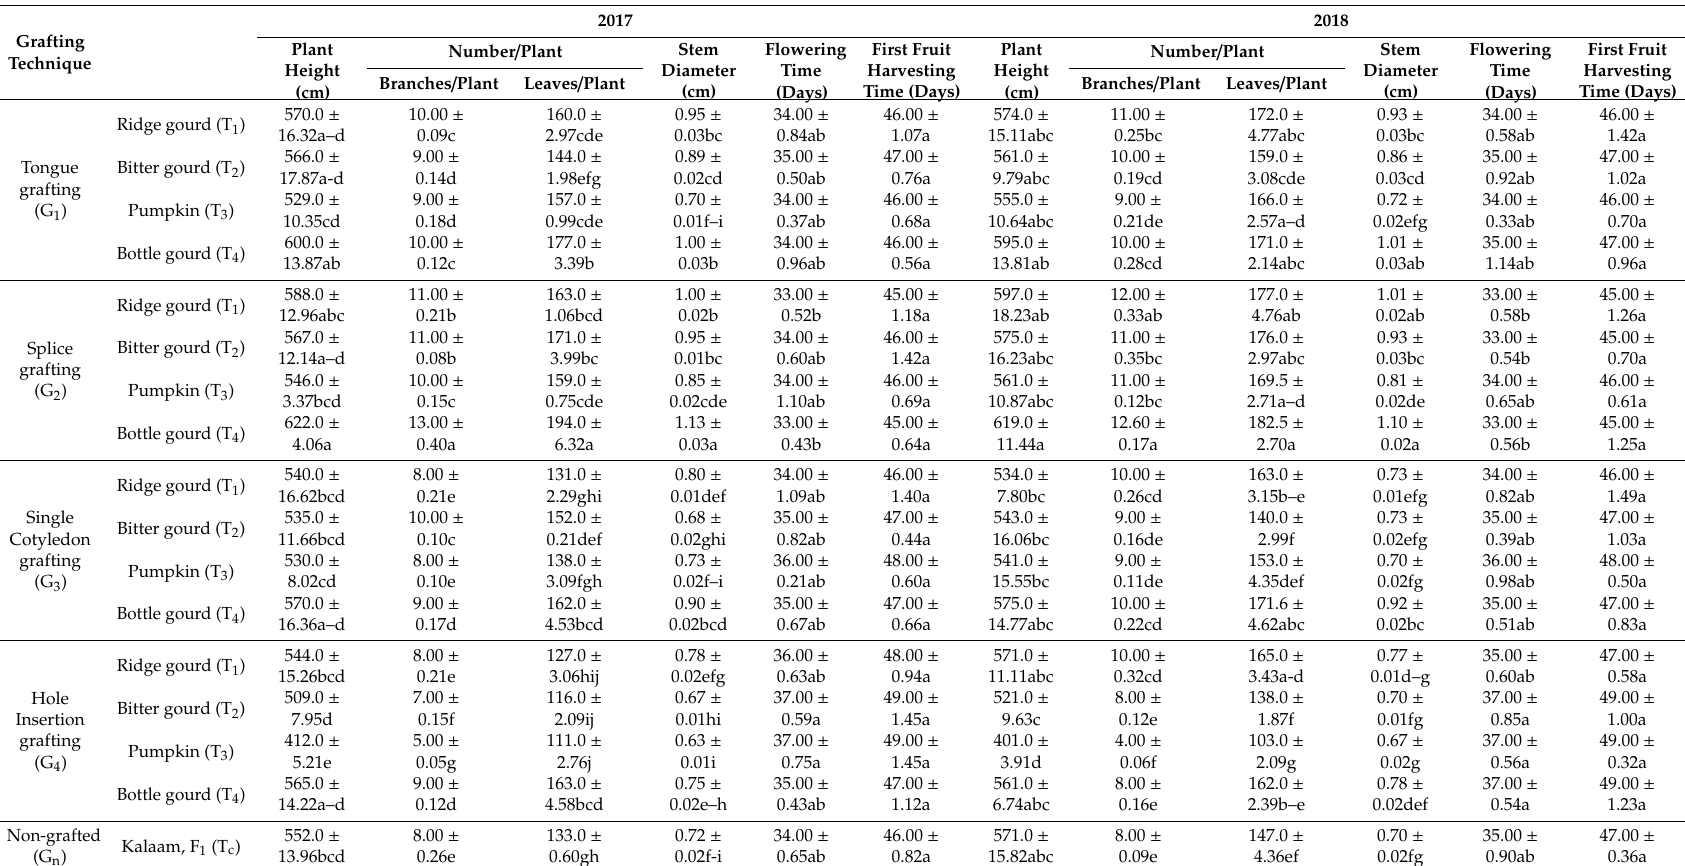
Table 3. E ff ect of Scion / rootstocks combinations (grafting) on cucumber growth at harvesting stage. Grafting